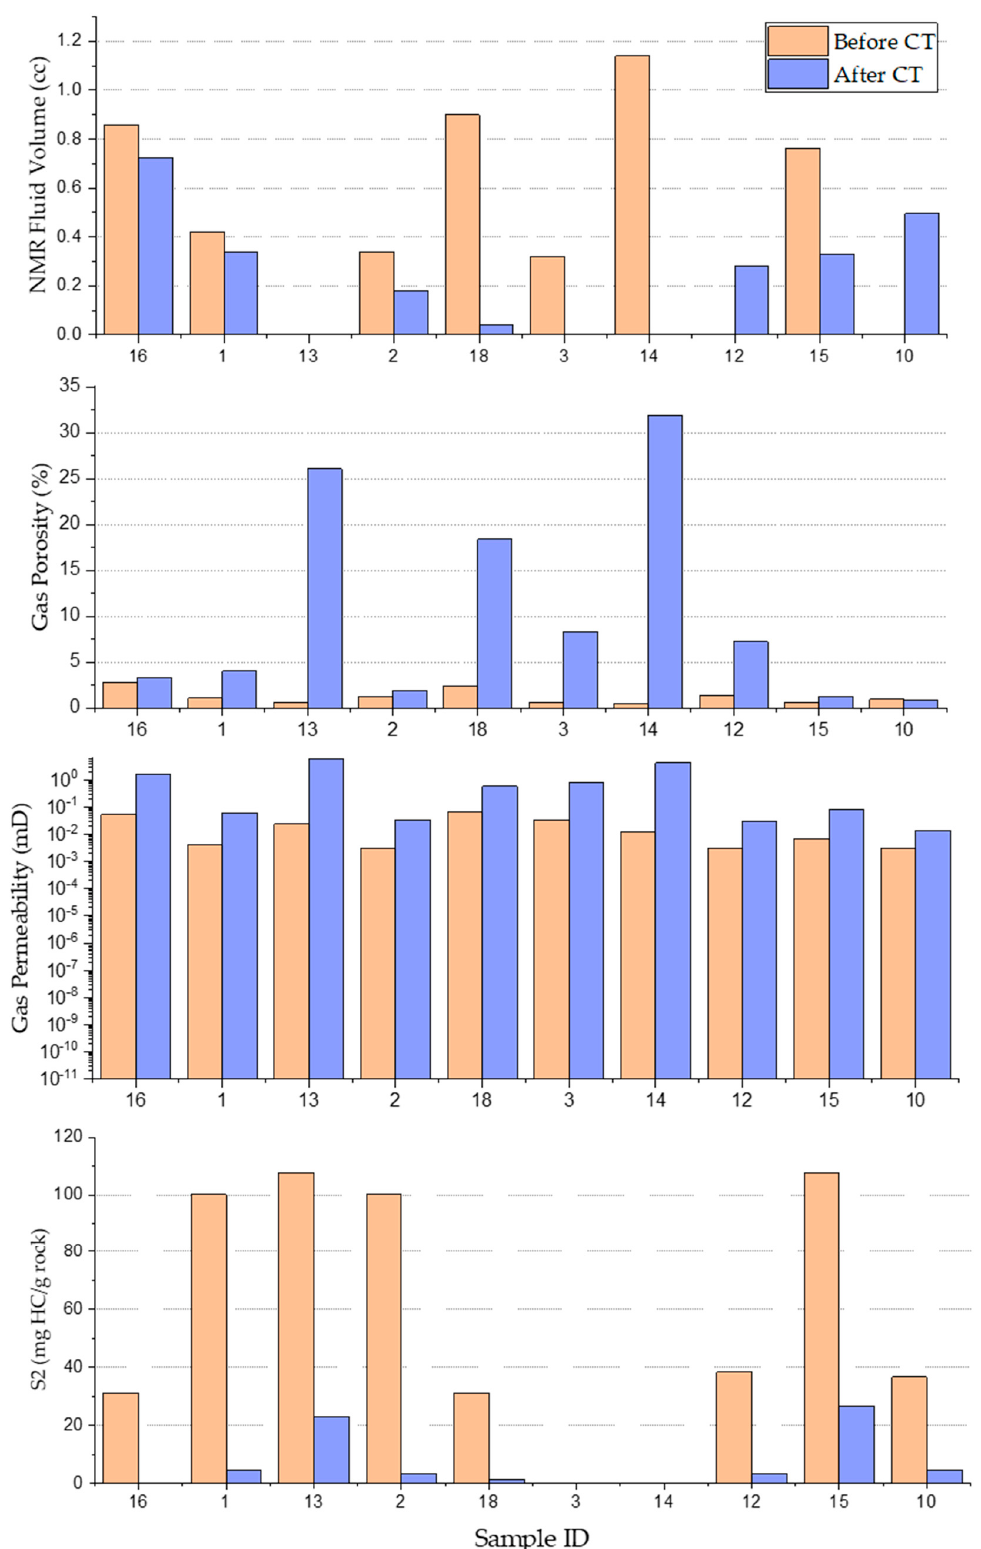
Figure A4. Gas porosity and permeability, NMR fluid volume, and TOC content before and after the combustion. Samples are located along the tube length, and sections counted from left to right, similar to the combustion front propagation.